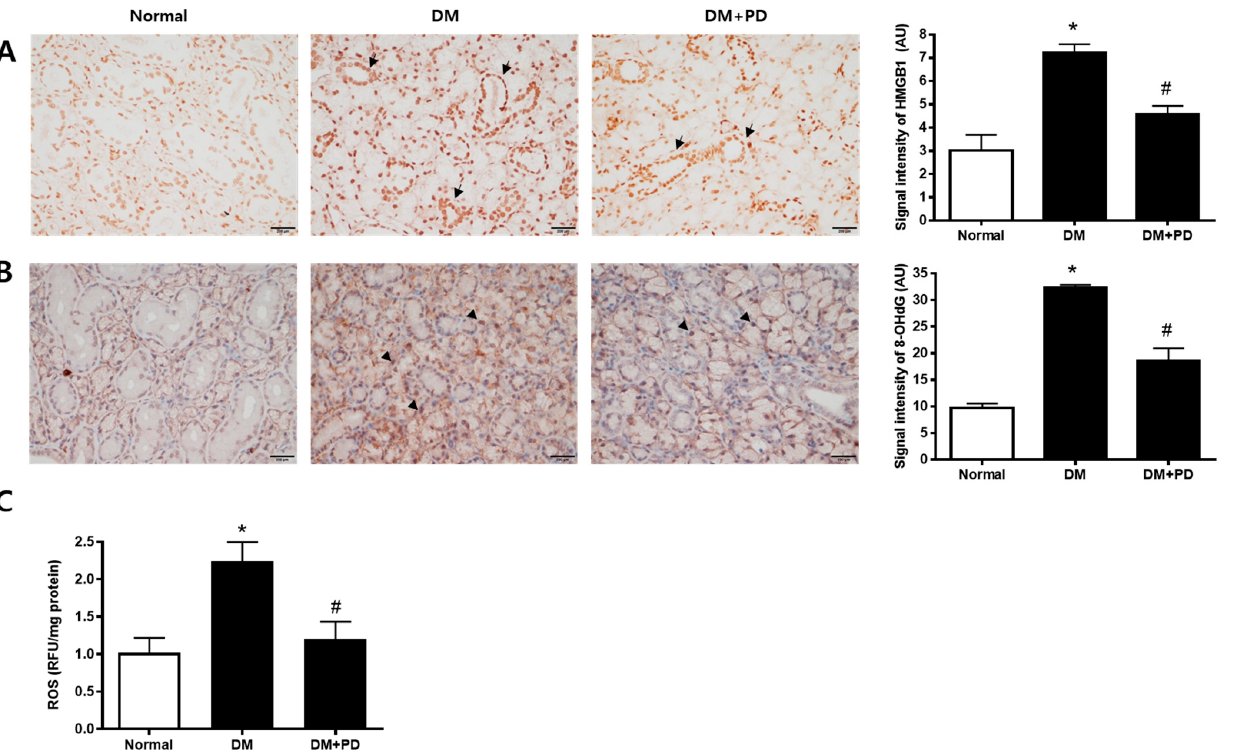
Figure 5. Effect of polydatin on ROS generation in submandibular glands. ( A ) Immunohistochemical staining for HMGB1. Quantification of the HMGB1 signal intensity. Arrows indicate HMGB1 positively stained cells. ( B ) Immunohistochemical staining for 8-OHdG. Quantification of the 8-OHdG signal intensity. Arrowheads indicate 8-OHdG positively stained cells. ( C ) ELISA assay for ROS in the salivary gland. Data are presented as the mean ± standard deviation ( n = 7). * p < 0.05 vs. Normal group; # p < 0.05 vs. DM group.